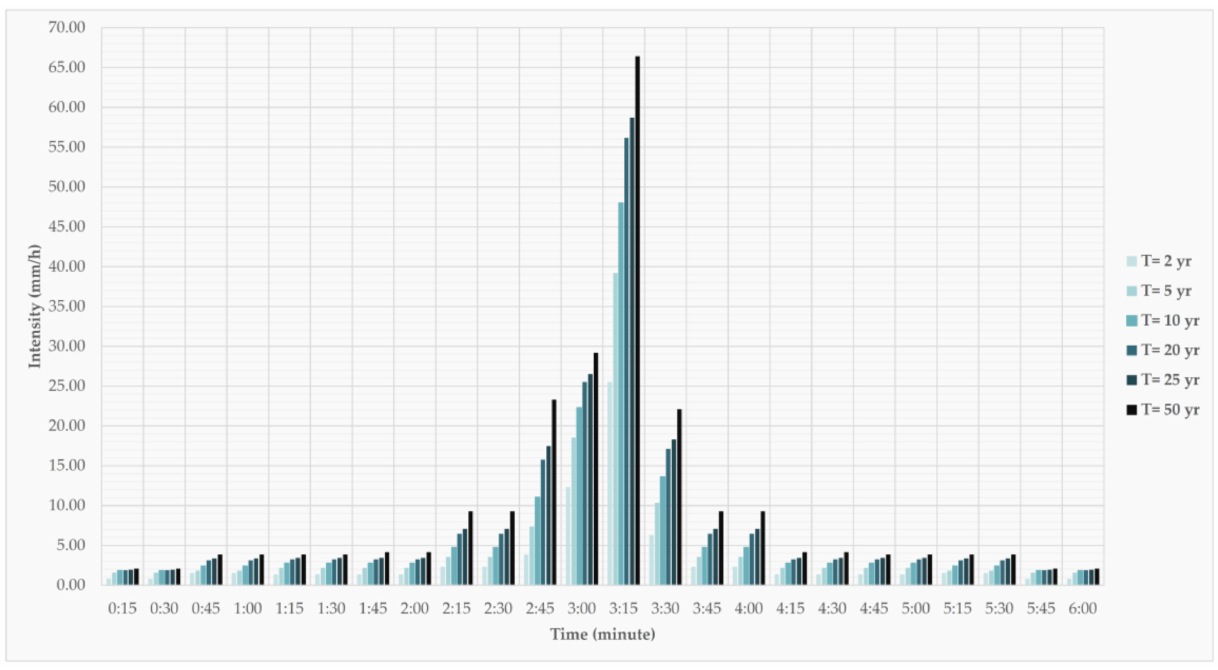
Figure 4. Synthetic design storms with different return periods for the city of Ahvaz.